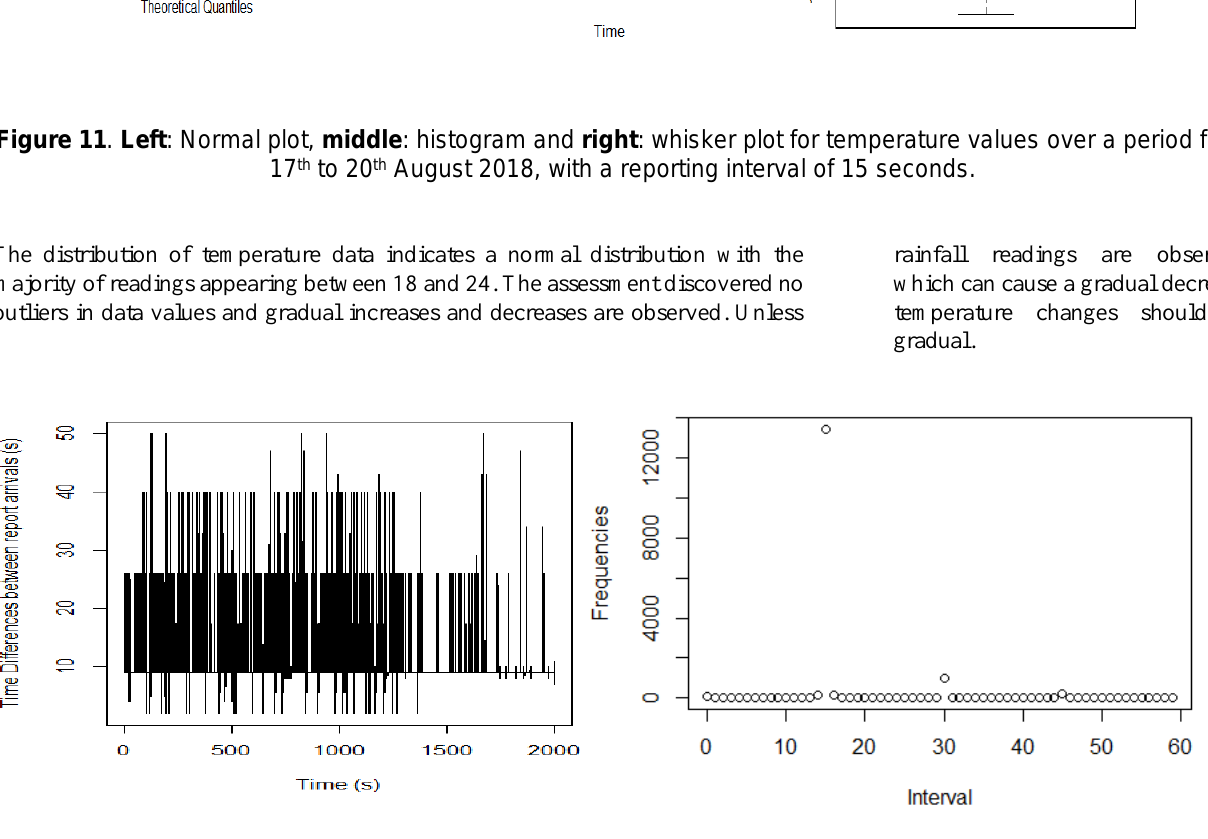
Figure 12 . Left : Differences in reporting intervals (clusters) for the 10m node. Right : The number of clusters formed from reporting interval